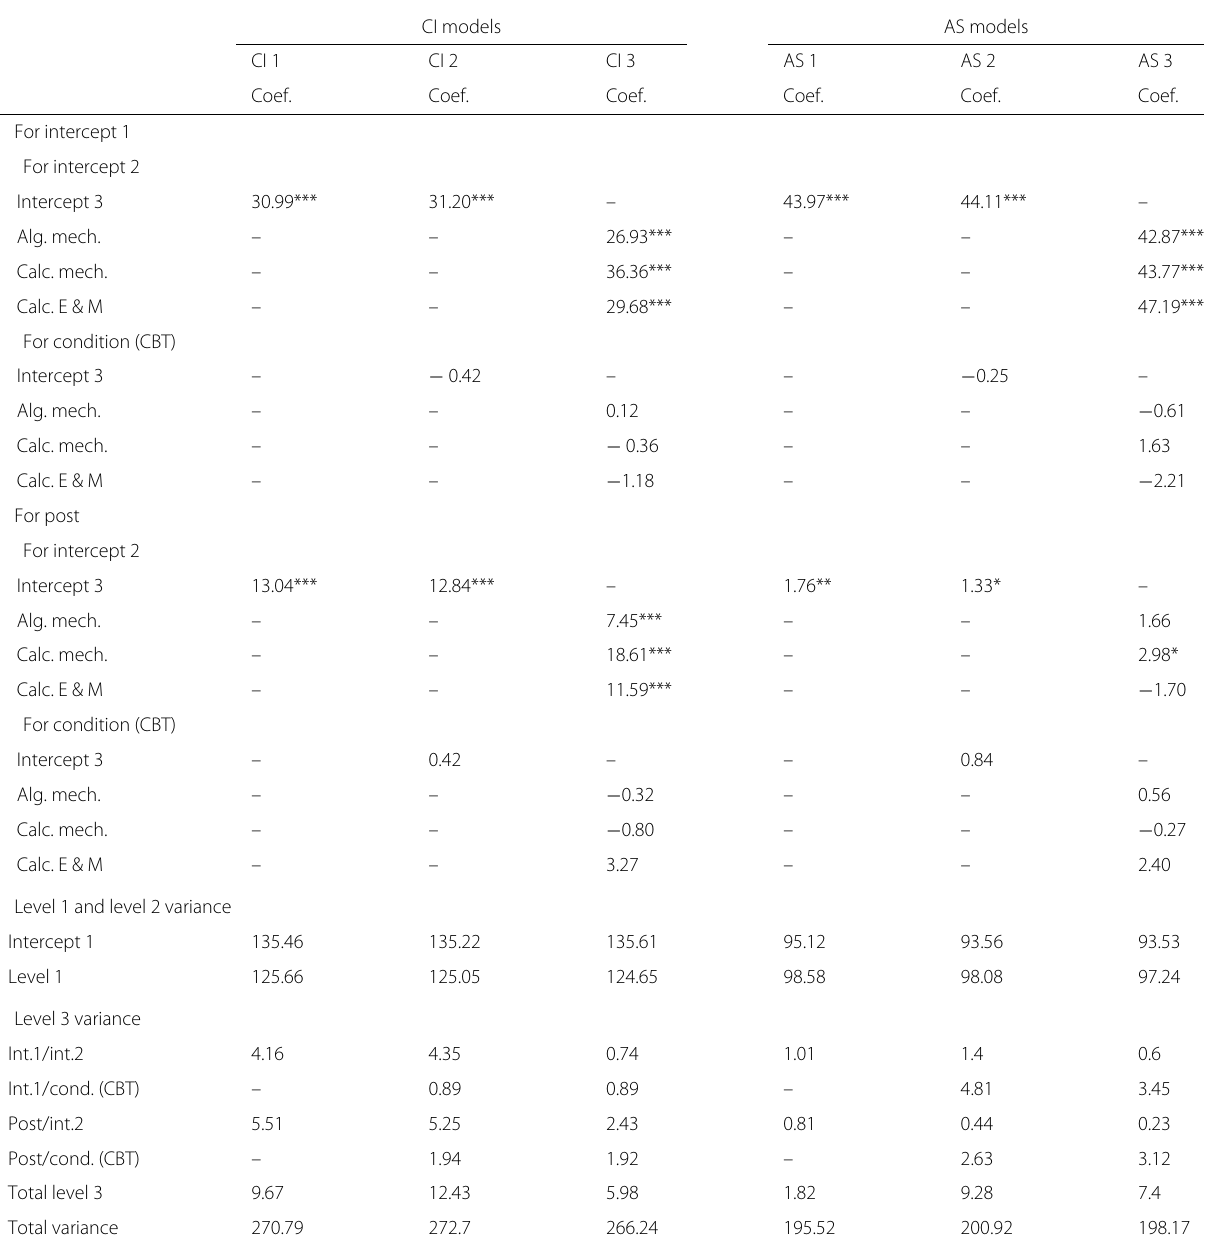
Table 6 HLMs comparing performance between PPT and CBT administered assessments for the CI and AS Final estimation of fixed effects with robust standard